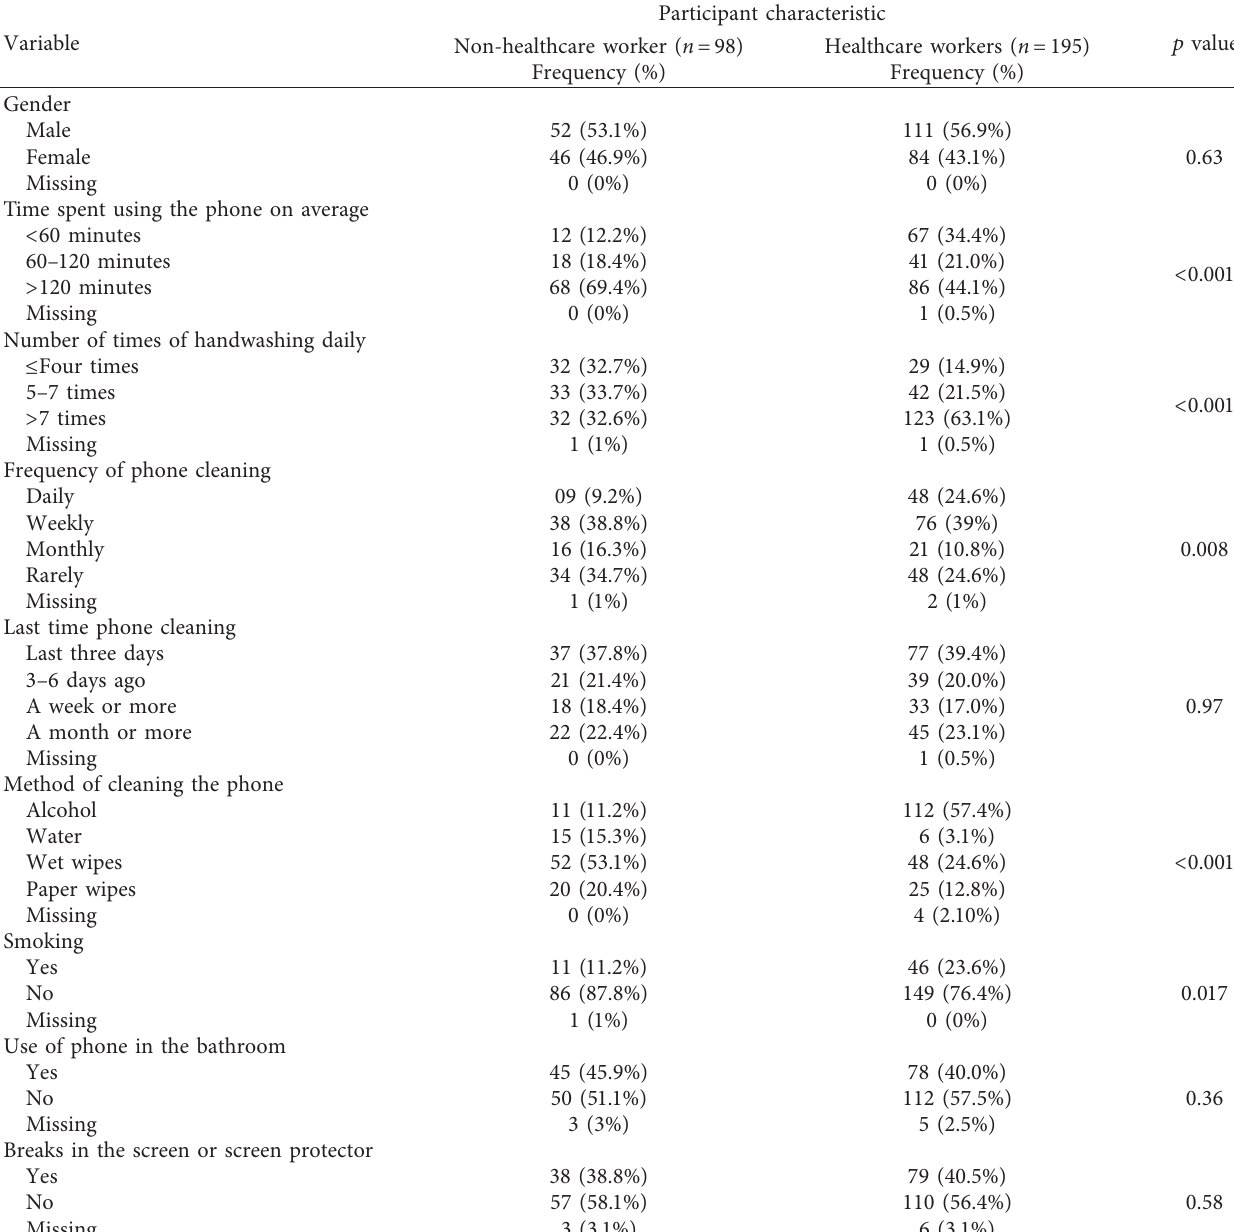
Table 1: Background variables of the